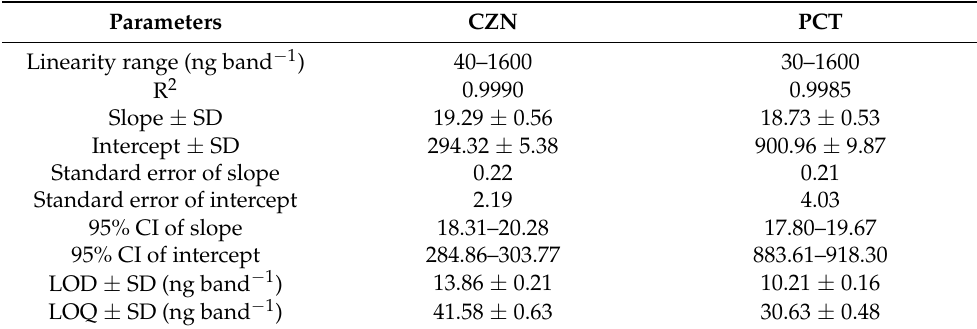
Table 1. Results for linearity evaluation for simultaneous detection of chlorzoxazone (CZN) and parac- etamol (PCT) using the greener high-performance thin-layer chromatography ultraviolet (HPTLC-UV) methodology (mean ± SD; n = 6).